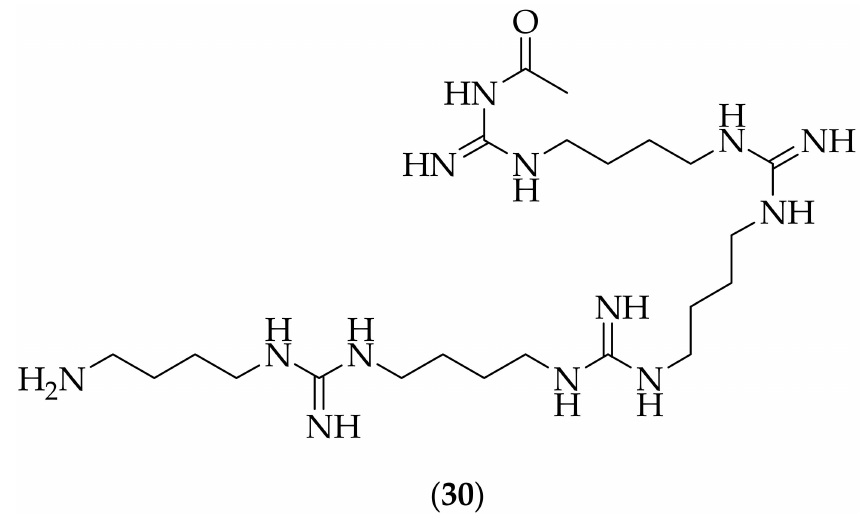
Figure 18. Structure of cabanillasin ( 30